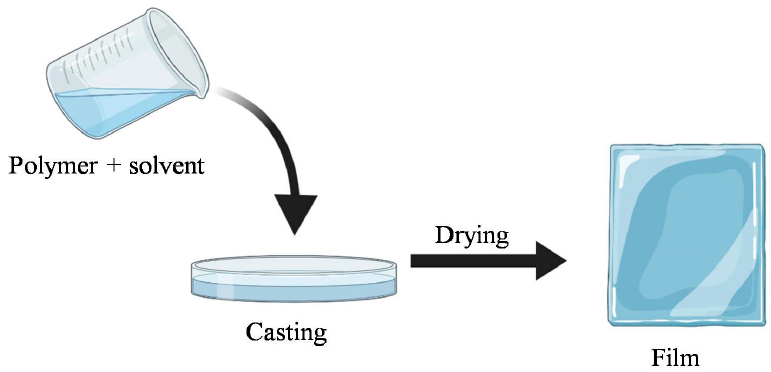
Figure 1. Casting